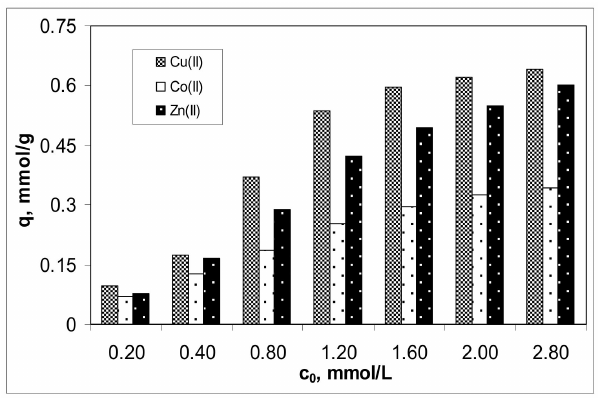
Figure 4. Effect of initial metal ions concentration on biosorption of Cu(II), Co(II) and Zn(II) ions on Alg-Fe 3 O 4 -MPs. (Experimental conditions: pH = 5.4; adsorbent dosage = 2.0 g/L; contact time = 24 h; temperature = 23 ◦